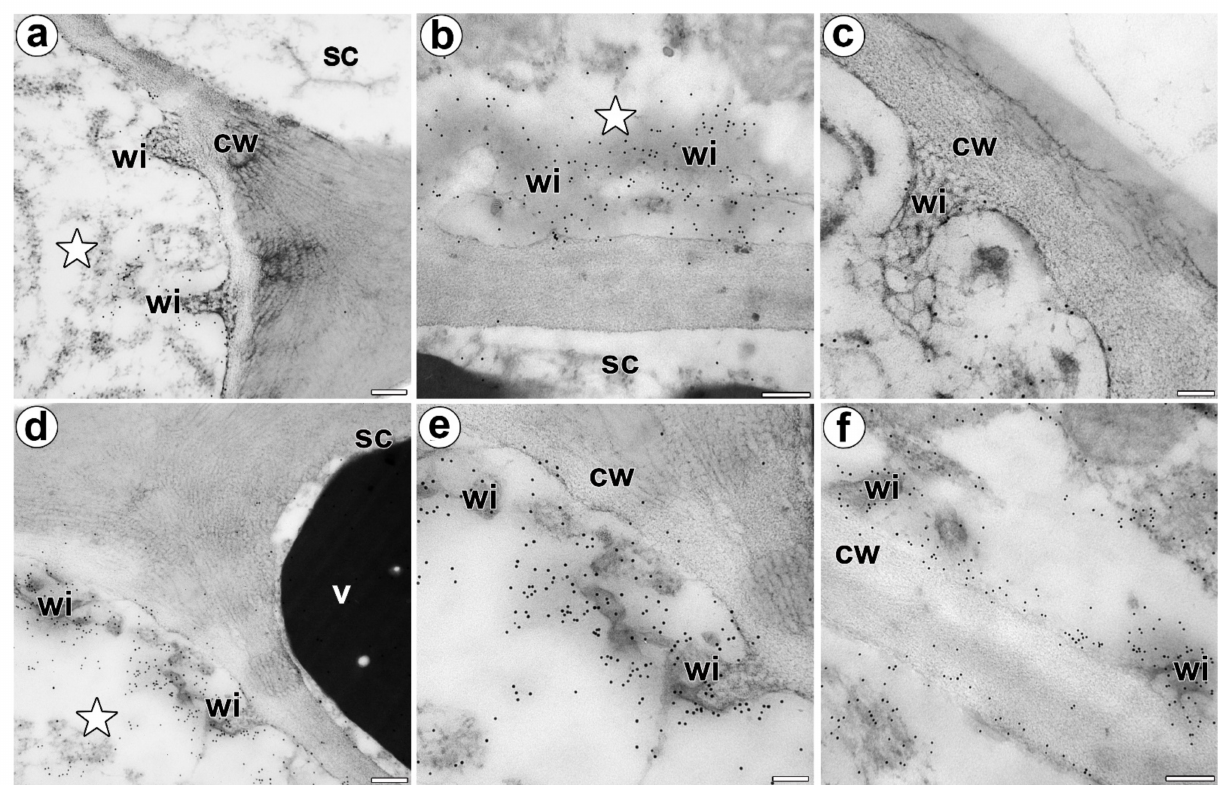
Figure 5. Immunolocalization of the AGP in the cell walls of a D. muscipula digestive gland. ( a ) Immunogold labeling of the wall ingrowths with JIM14, a gland from an unfed trap: secretory cell (star), stem cell (sc), wall ingrowths (wi), cell wall (cw), bar 200 nm. ( b ) Immunogold labeling of the wall ingrowths with JIM14, a gland two hours after feeding: secretory cell (star), stem cell (sc), wall ingrowths (wi), bar 200 nm. ( c ) Immunogold labeling of the wall ingrowths with JIM8 in the secretory cell, a gland three days after feeding: wall ingrowths (wi), cell wall (cw), bar 100 nm. ( d ) Immunogold labeling of wall ingrowths with JIM13, in a gland three days after feeding: secretory cell (star), stem cell (sc), wall ingrowths (wi), cell wall (cw), vacuole (v), bar 200 nm. ( e , f ) Immunogold labeling of the wall ingrowths with JIM13 in the secretory cells, a gland three days after feeding: wall ingrowths (wi), cell wall (cw), bar 100 nm and bar 200